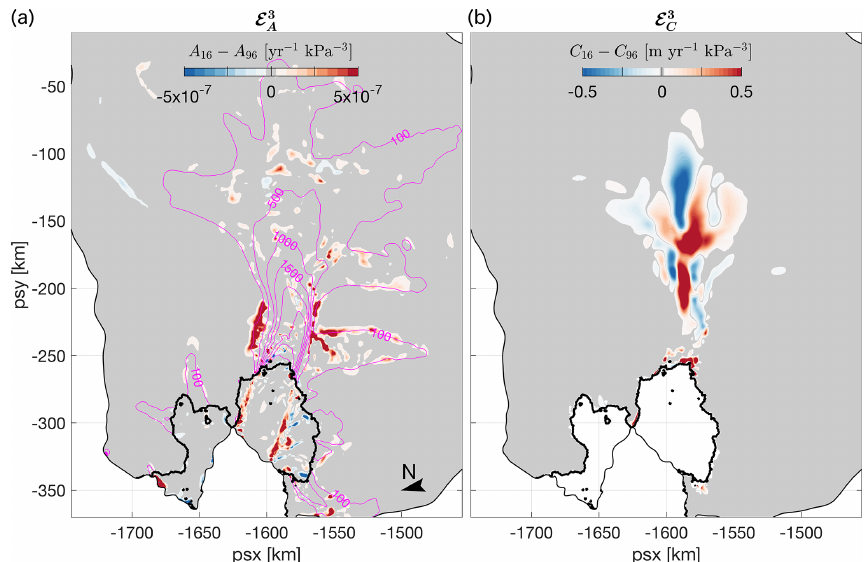
Figure 4. (a) Results for the E 3 experiment: changes in the rate factor A required to fully reproduce observed changes in surface speed of A the ice shelf and grounded ice between the years 1996 and 2016. The sliding exponent m = 3 and basal slipperiness C were kept fixed for grounded areas. Magenta contours (in myr − 1 ) correspond to the surface speed in 2016. (b) Results for the E 3 basal slipperiness C required to reproduce the observed increase in surface speed of the grounded ice between 1996 and 2016. The rate factor A is assumed constant between 1996 and